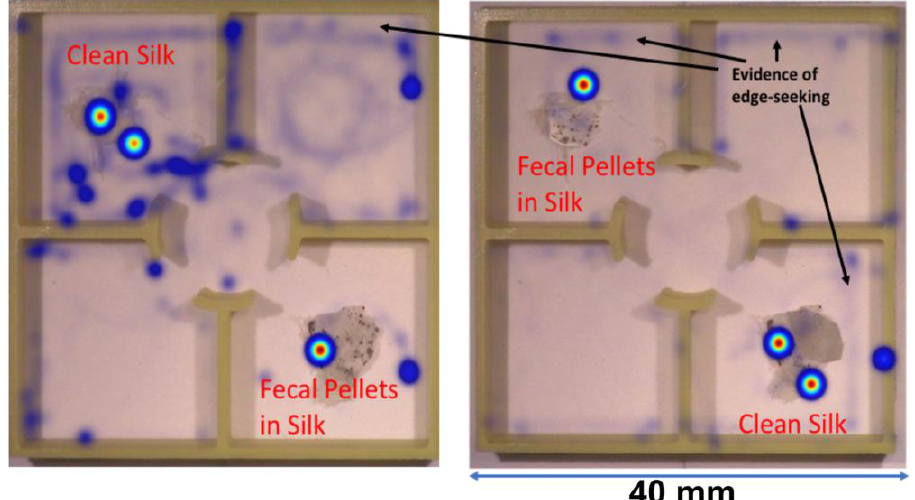
Figure 2. Heatmaps showing an overlay of three separate trials for each set-up ( n = 6). Yellow and red (hot colors) indicate longer periods of time, whilst blue indicates less time in a zone. Brightly colored circles in each arena reflect the tendency for each of the bugs to settle under the silk patch once it was found. The lighter colored blue lines show, where bugs tended to walk. The blue circles show where they sat for longer periods of time.